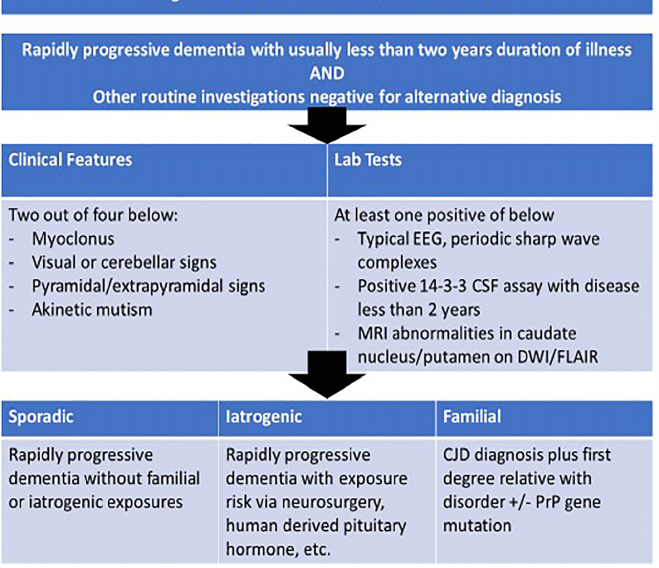
Figure. The diagnostic criteria for Creutzfeldt-Jakob disease. 9 Amended from Centers for Disease Control and Prevention diagnostic criteria. EEG, electroencephalogram; CSF, cerebrospinal fluid; MRI, magnetic resonance imaging; DWI, diffusion-weighted imaging; FLAIR, fluid attenuated inversion